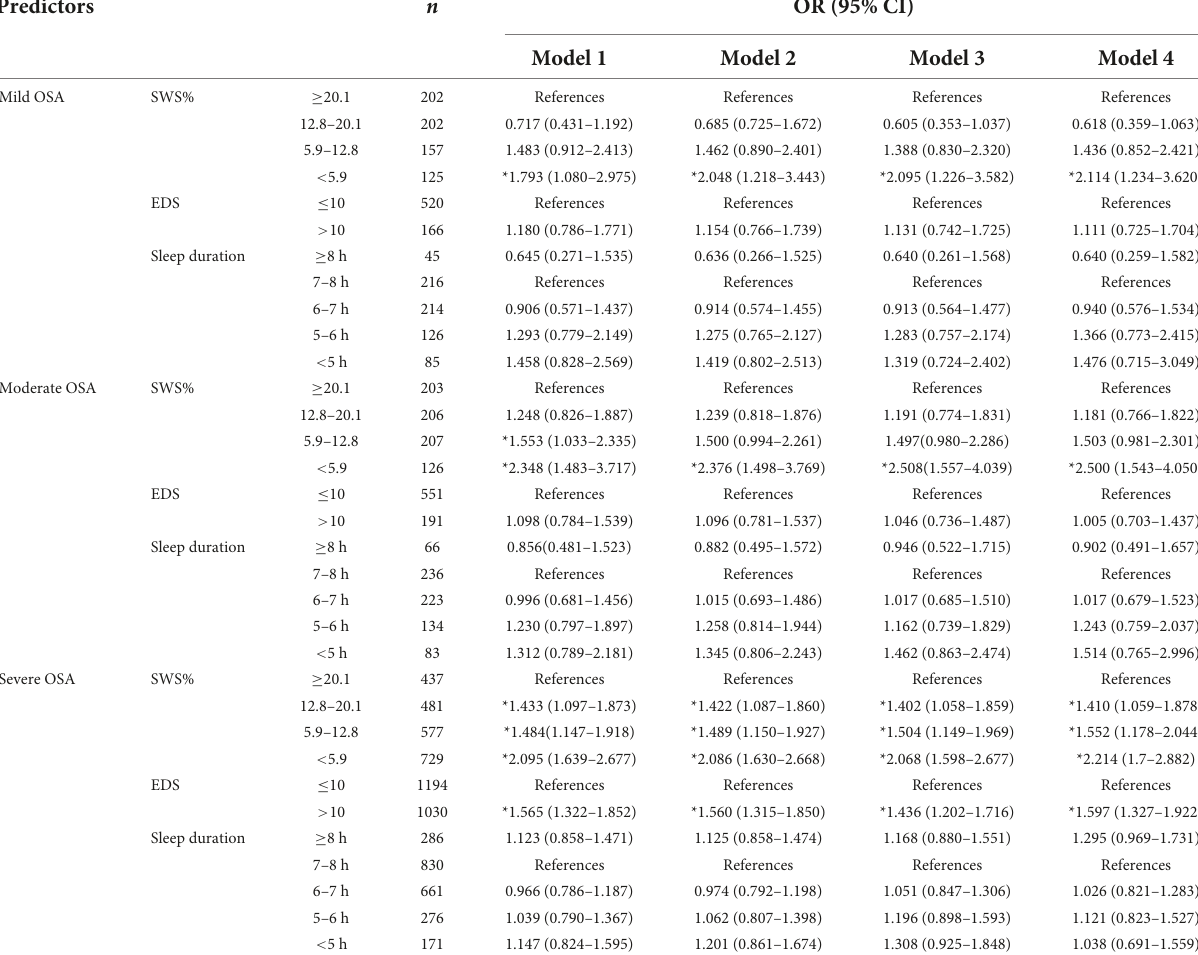
TABLE 5 Association of SWS, EDS, SSD and moderate-to-high Framingham risk in stratified analysis by OSA